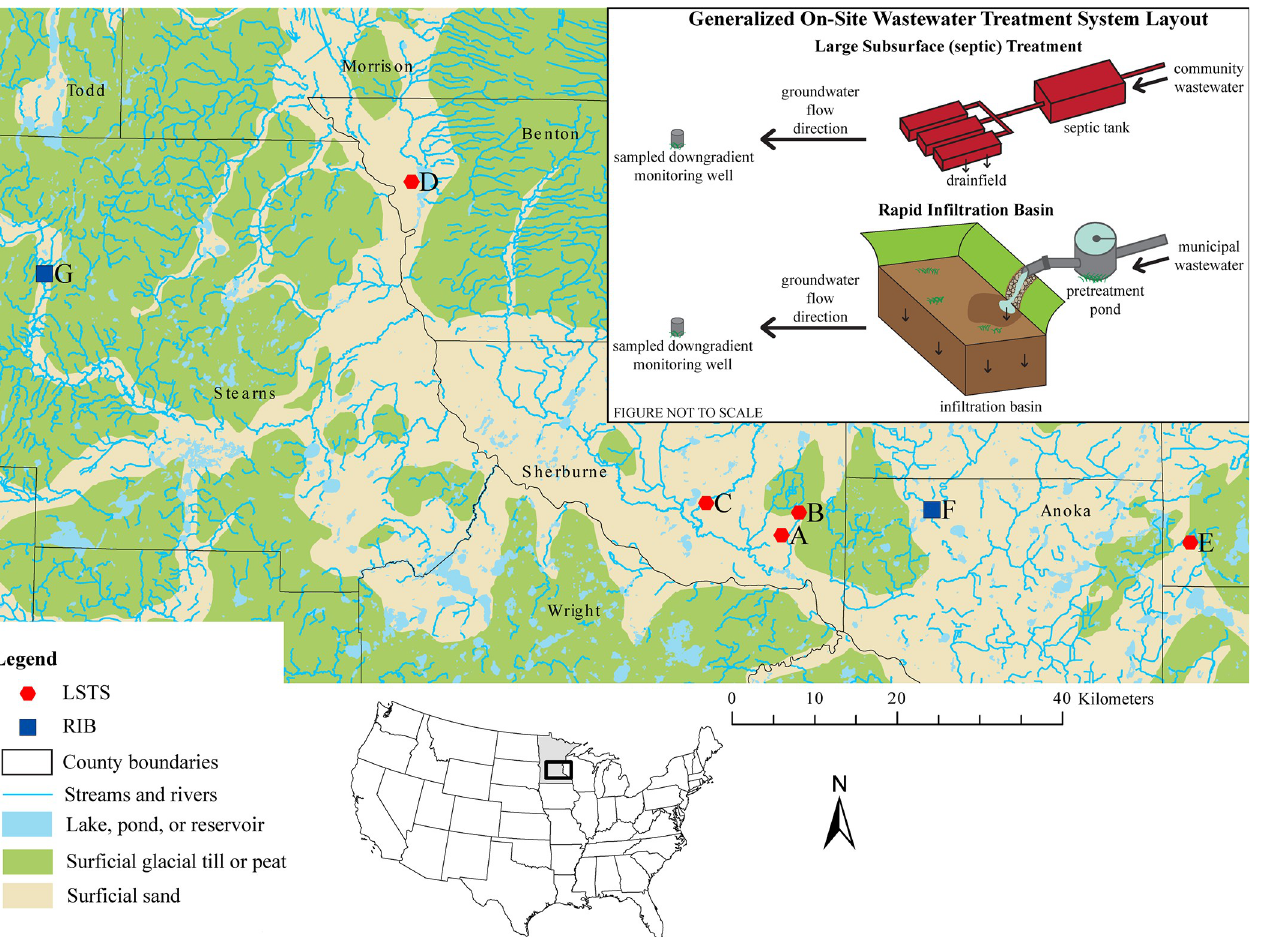
Fig 1. Location of on-site wastewater treatment facilities sampled in Central Minnesota, USA. Basemap from Hobbs and Goebel [26]. LSTS, large subsurface treatment system; RIB, rapid infiltration